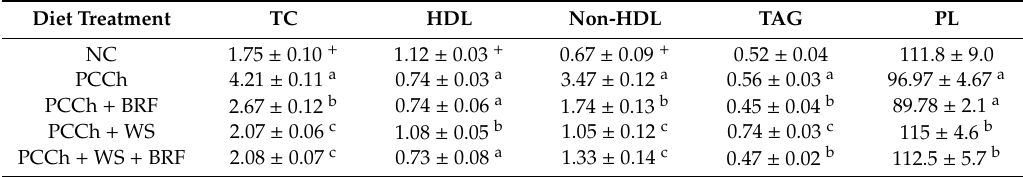
Table 1. Lipid profile in the plasma of rats fed experimental